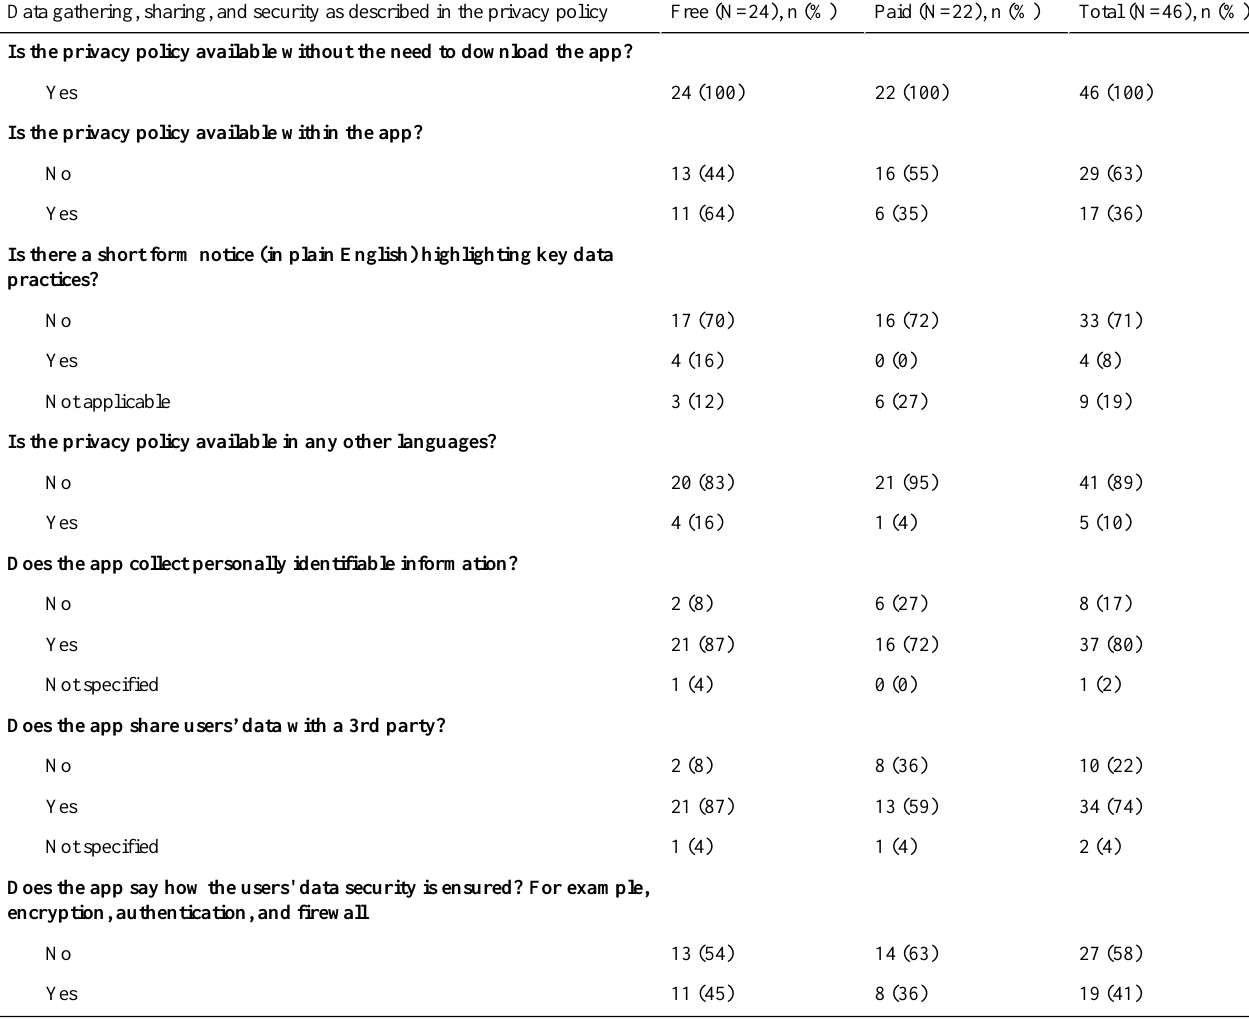
Table 4. Data gathering, sharing and security as described in the privacy policy (within those that had the policy, N=46). Note: 29% (19/65) did not have a privacy policy available.